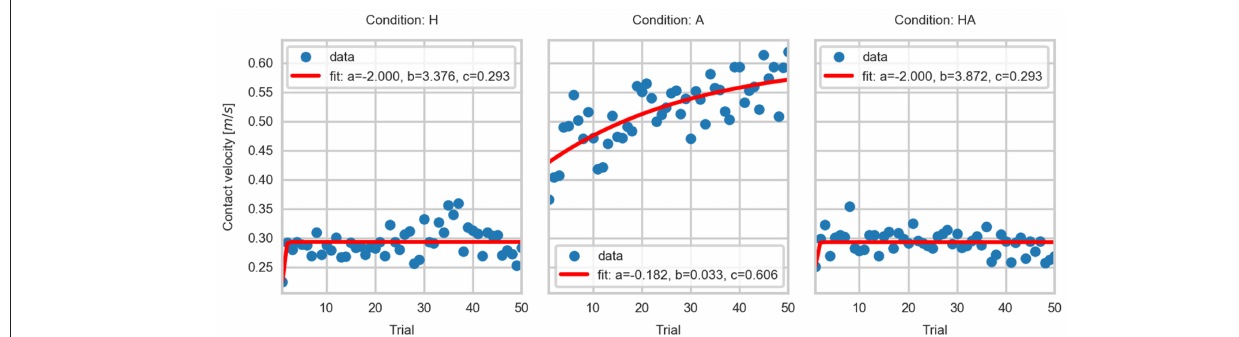
FIGURE 11 | Exponential fits to the contact velocity data.